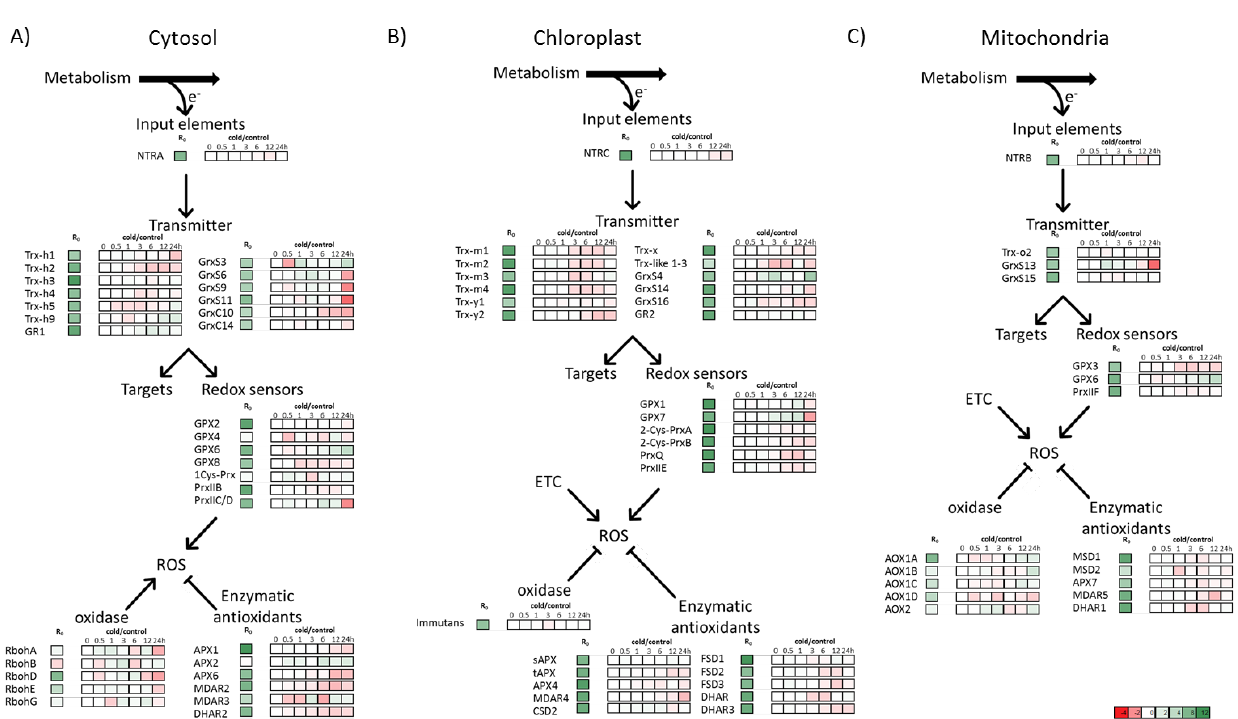
Figure 2. Time-dependent change in transcript levels of the redox regulatory network in the cytosol ( A ), chloroplast ( B ), and mitochondrion ( C ) during chilling stress. Relative transcript levels in A. thaliana were obtained from the Gene Expression Omnibus (GEO) Database of National Center for Biotechnology Information (NCBI) (Accession GSE5620 for control conditions and GSE5621 for low temperature treated plants) [8]. R0 shows the transcription level normalized by the Affymetrix system. The other boxes indicate the transcript levels in cold treated plants compared to the control conditions at the depicted time point. A complete list with the precise log2-fold changes is provided in the supplement. AOX: Alternative oxidase; APX: Ascorbate peroxidase; CSD: Cu/Zn-superoxide dismutase; DHAR: Dehydroascorbate reductase; ETC: electron transport chain; FSD: Fe-superoxide dismutase; GR: Glutathione reductase; GRX: Glutaredoxin; GPX: Glutathione peroxidase; MDAR: Monodehydroascorbate reductase; NTR: NADPH-dependent thioredoxin reductase; PRX: Peroxiredoxin; Rboh: Respiratory burst oxidase homolog protein; TRX: Thioredoxin. The assignment of subcellular localization of the proteins listed in this figure was based on the references [42–72], see also Table S1.